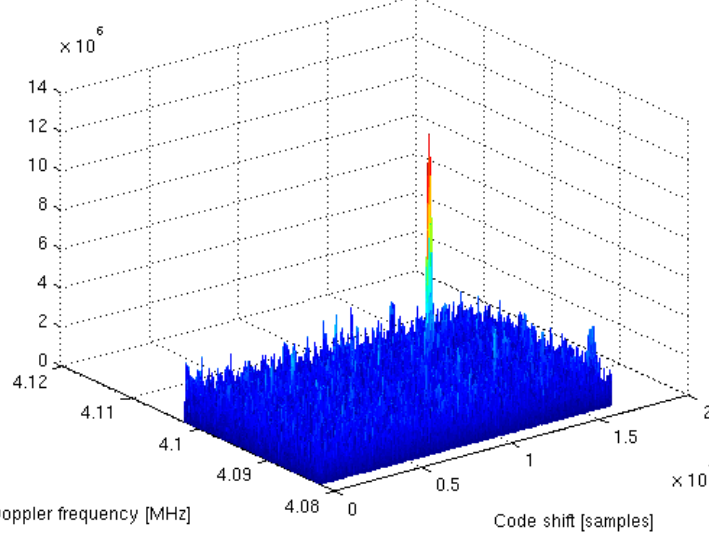
Figure 27. GPS L1 acquisition results obtained with a CCNV1-A1 and in-house developed antenna with a 1 ms acquisition time.